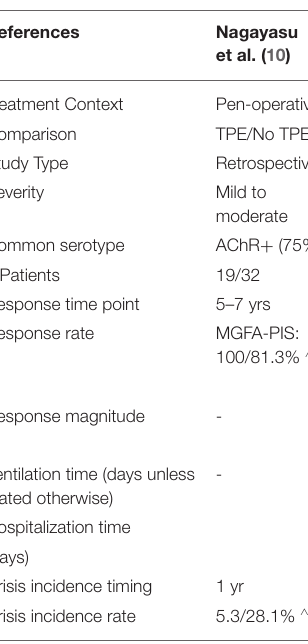
TABLE 5 | Pre-thymectomy TPE comparative efficacy